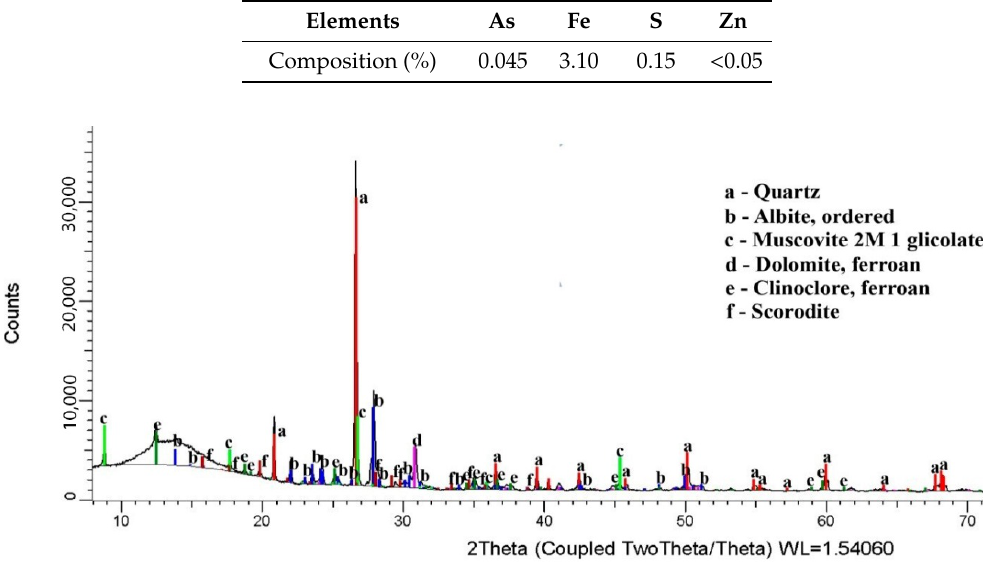
Table 1. The selected elemental content of mine tailings determined by ICP-OES analysis.